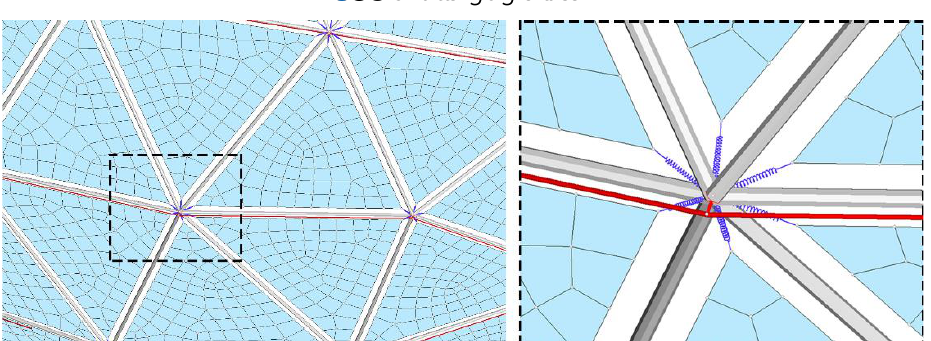
Fig. 8 FE modelling strategy adopted for the global analyses: dimensionless node and elements merging on